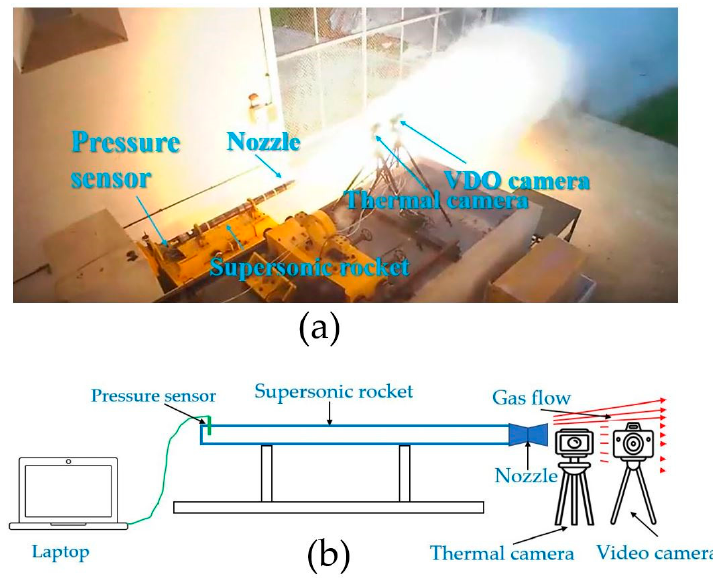
Figure 5. A static experiment: ( a ) actual image and ( b ) diagram.